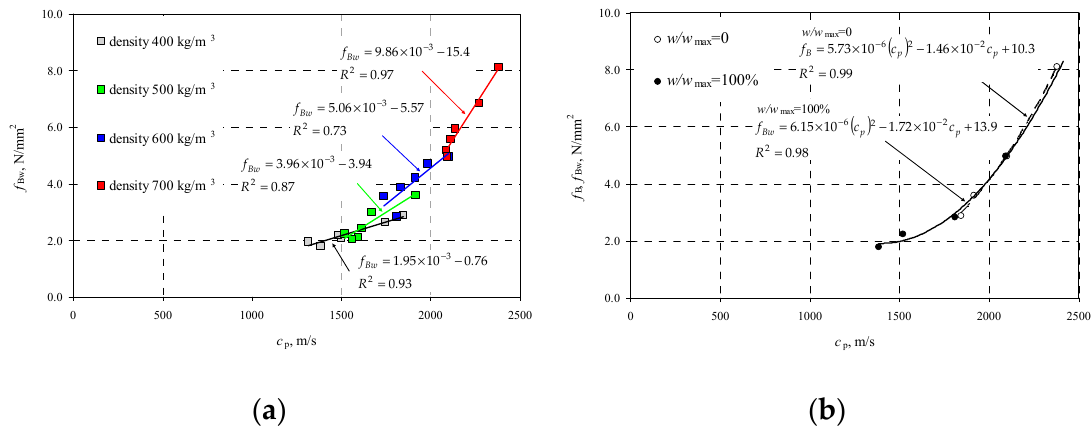
Figure 8. Results from P-waves velocity testing: ( a ) compressive strength of AAC including density classes, and ( b ) AAC strength in wet concrete ( f Bw ) and totally dry concrete ( f B ).